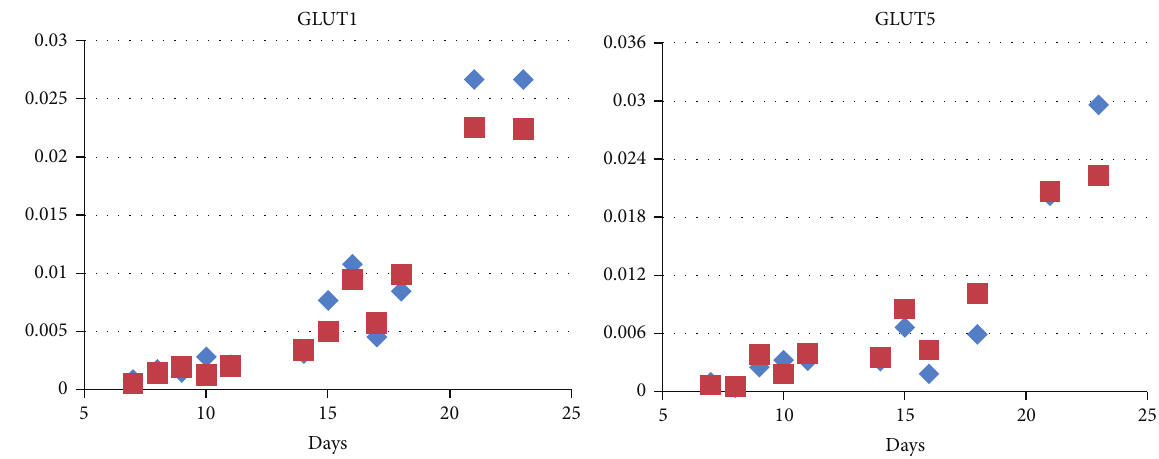
Figure 2: Expression of the glucose transporter GLUT1 and the fructose transporter GLUT5. Both transport proteins exhibit a steep rise duringmaturation.However,nodifferenceisseenintheabsence(bluediamonds)andinthepresence(redsquares)offructose. 𝑦 -axis:relative expression compared to expression of actin mRNA. Each symbol depicts one qPCR measurement per dish in a representative experiment.